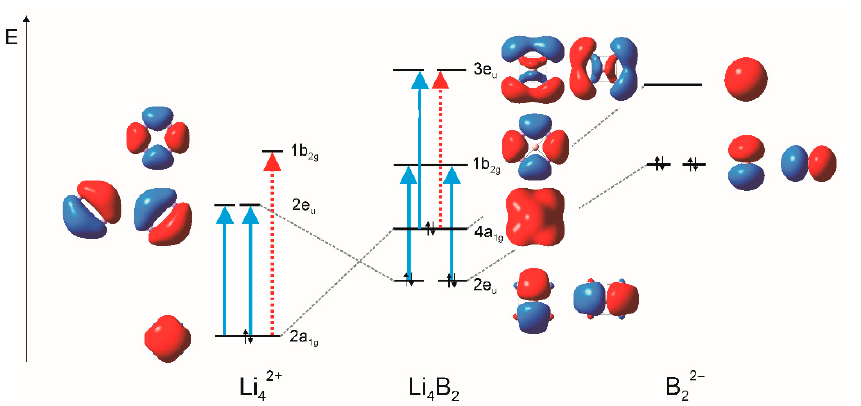
Figure 7. Orbital interaction diagram of Li 4 B 2 obtained at the M06-2X/def2-TZVP level of theory. Full (blue) arrows represent the main translational transitions, and dashed (red) arrows represent the main rotational transitions.